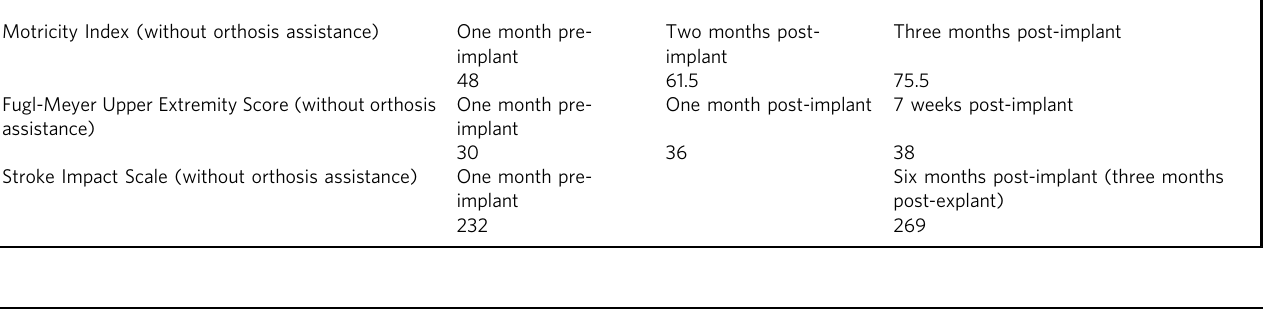
Table 3 Motricity Index, Fugl-Meyer, Stroke Impact Scale.